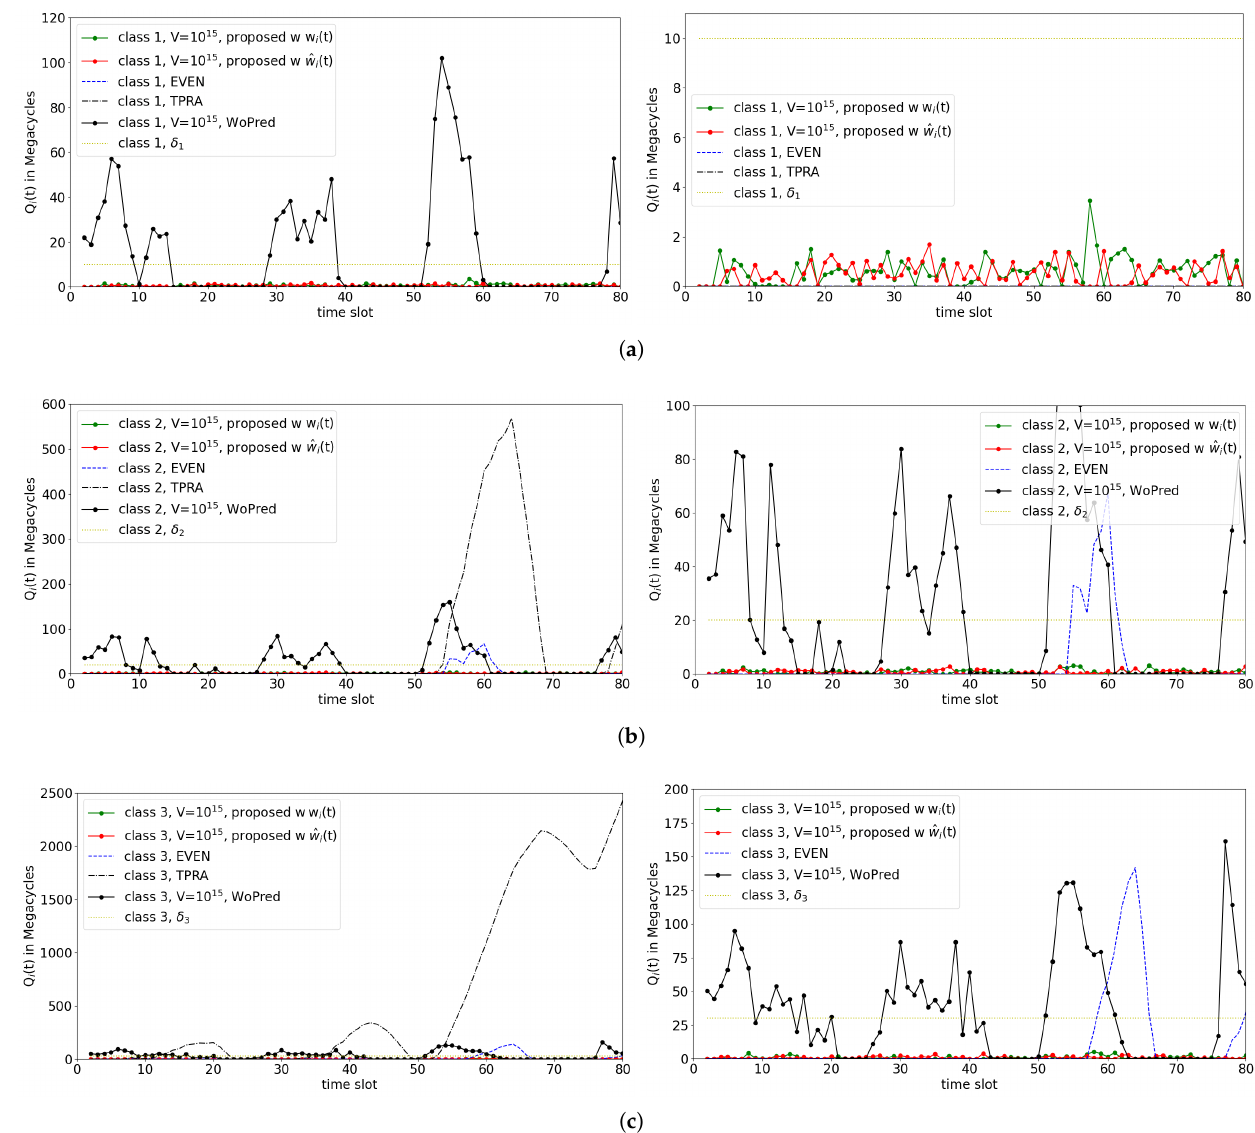
Figure 3. Comparison of Q i ( t ) for three classes. ( a ) Q 1 ( t ) over time, ( b ) Q 2 ( t ) over time, and ( c ) Q 3 ( t ) over